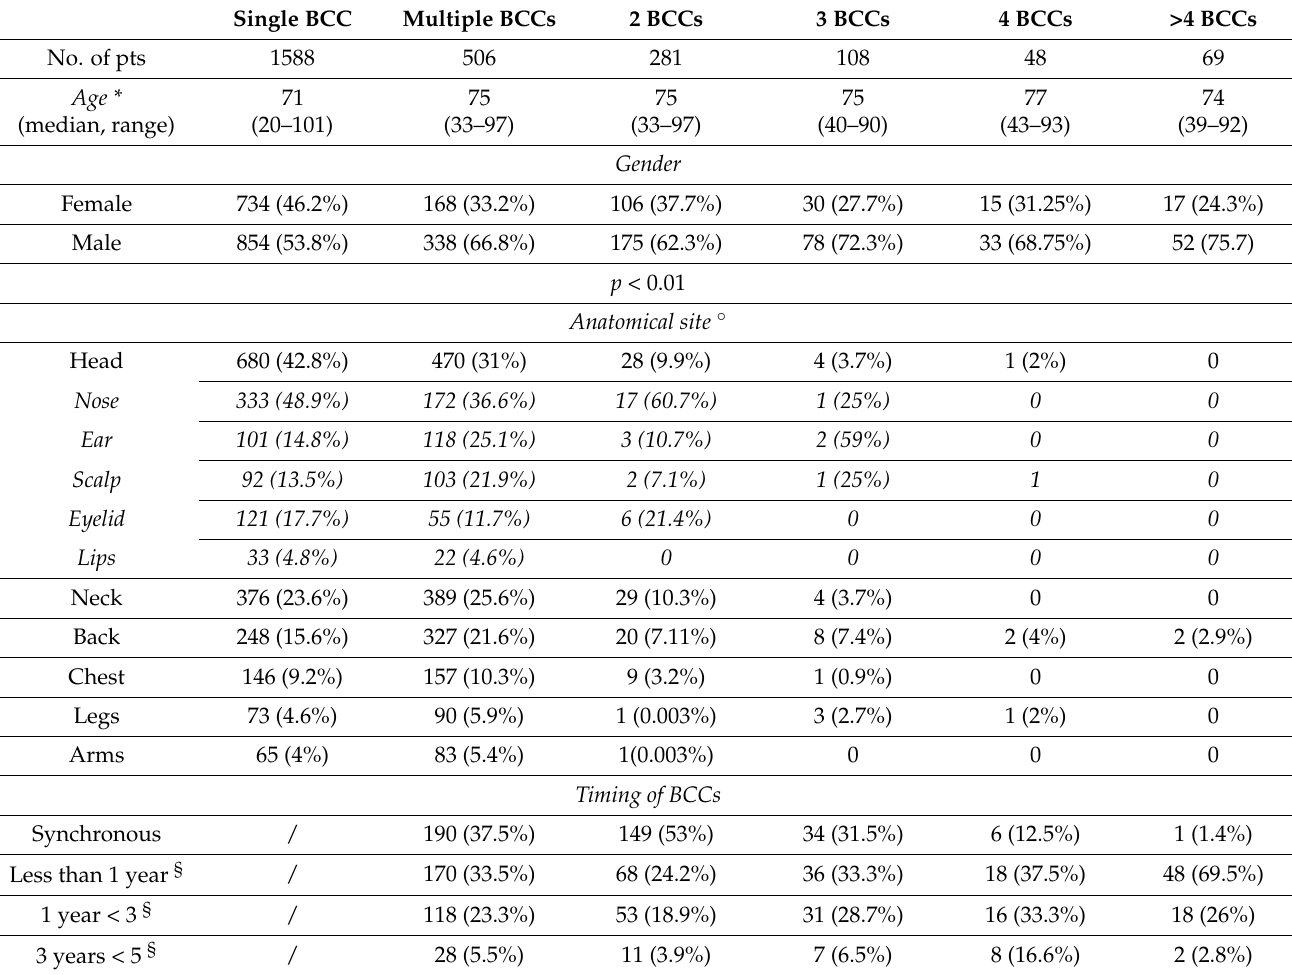
Table 3. Clinical characteristics of patients with single or multiple